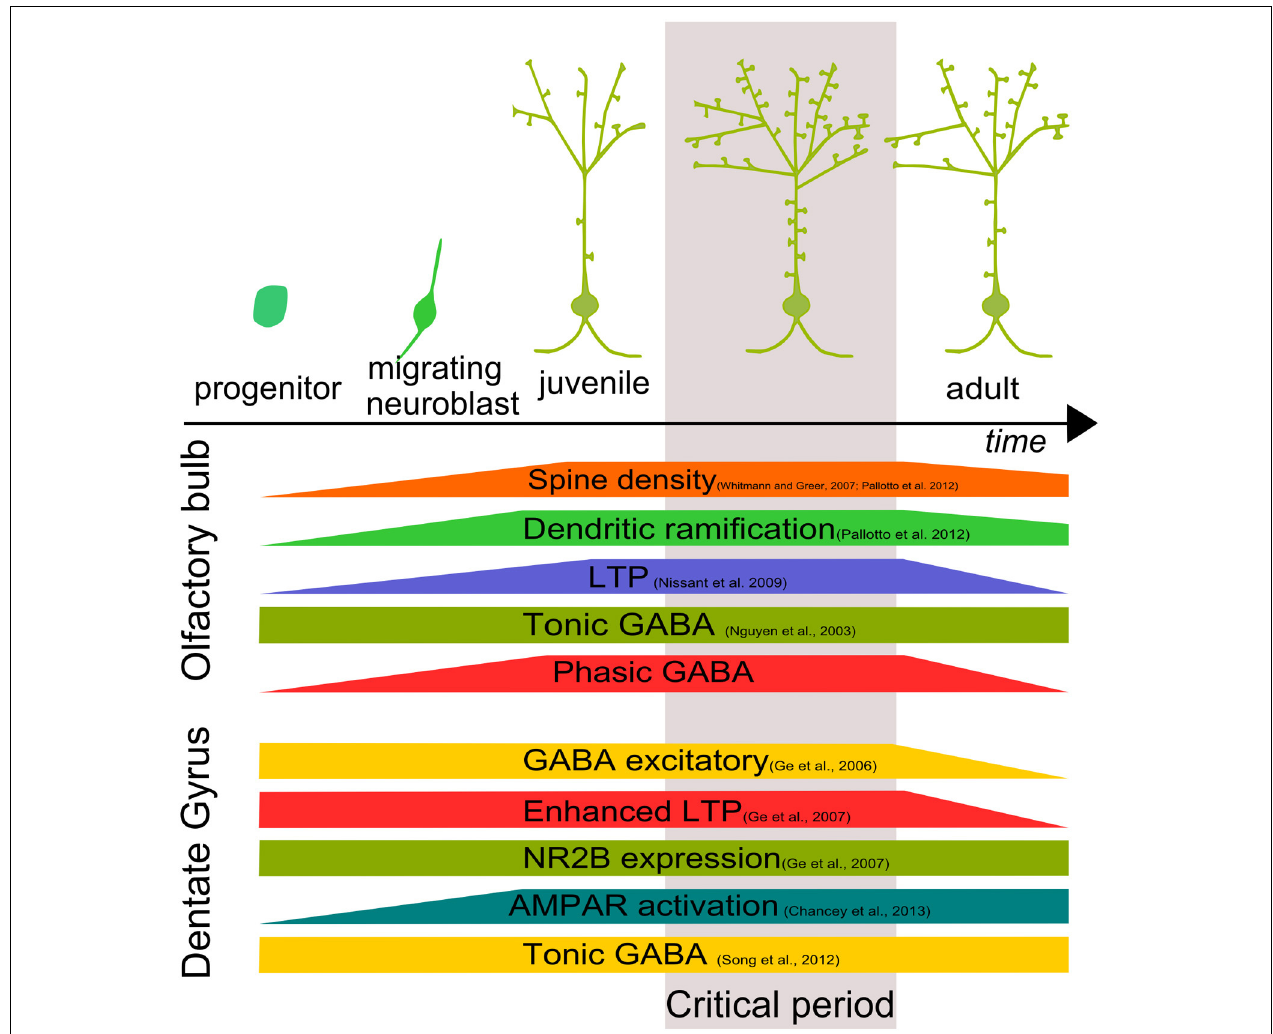
FIGURE 2 | Development and critical period of adult-born neurons. Adult–born GC growth is characterized by a time window in which morphological, biochemical and physiological characteristics are finely tuned both in the OB and DG defining a “critical period” for adult-born cell